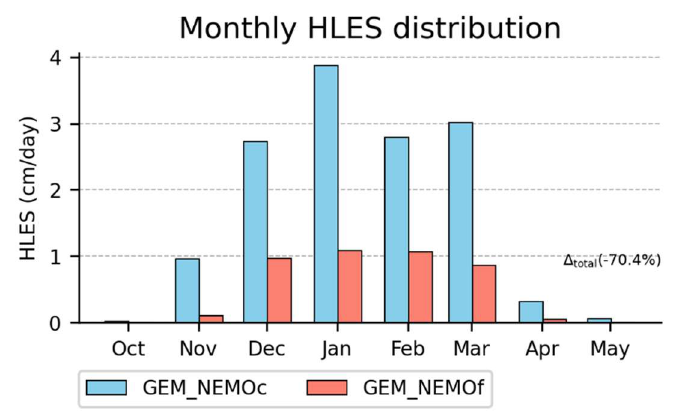
Figure 4. Modelled monthly distribution of area-averaged HLES (cm/day) for the current 1989–2010 (blue, GEM_NEMOc) and future 2079–2100 (red, GEM_NEMOf) periods.